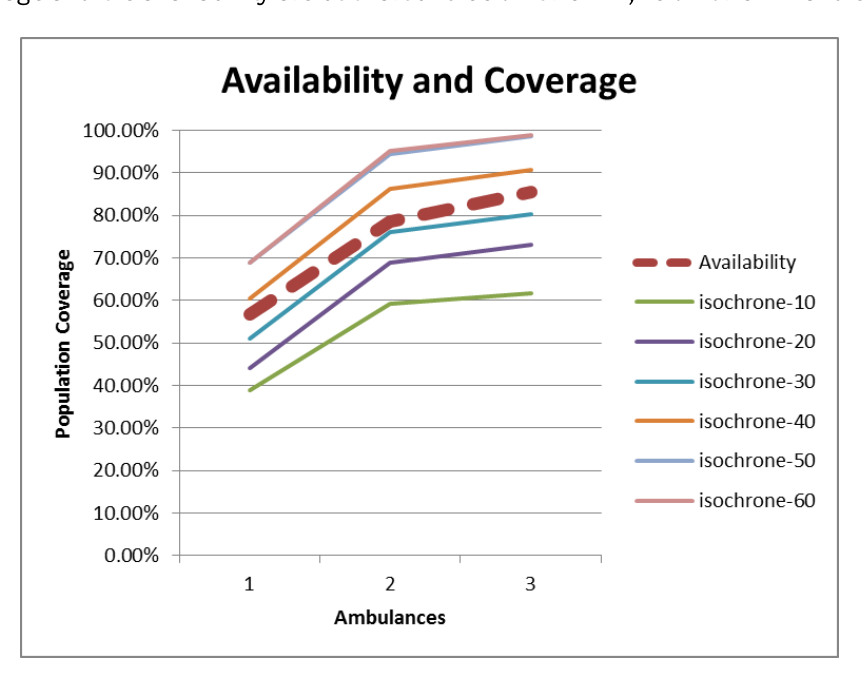
Figure 11. Relationship between population coverage and percent